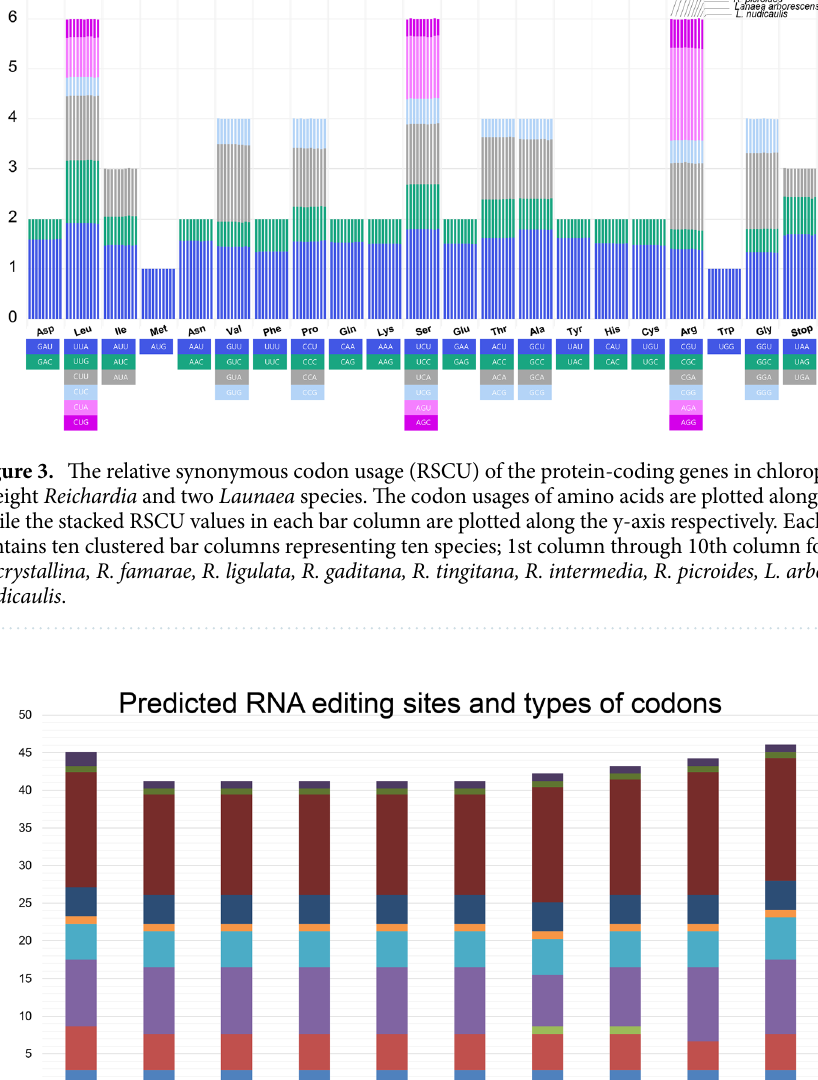
(average Pi value of 0.00283, ranging from 0 to 0.01593) belonging to the same subtribe Hyoseridinae 33 . Genetic polymorphisms in different regions of the chloroplast genome varied substantially. The SSC region, where the most variable gene, ycf1 , was located, was the most divergent (average Pi, 0.0102), whereas the two IR regions were highly conserved (average Pi, 0.00173). Six divergence hotspots among the Reichardia and Launaea plas- tomes are suggested as potential chloroplast markers: five intergenic regions ( trnH-psbA, trnC-petN, ndhC-trnV, trnL-rpl32 , and rpl32-ndhF ) and one protein-coding gene ( ycf1 ) (Fig. 6).